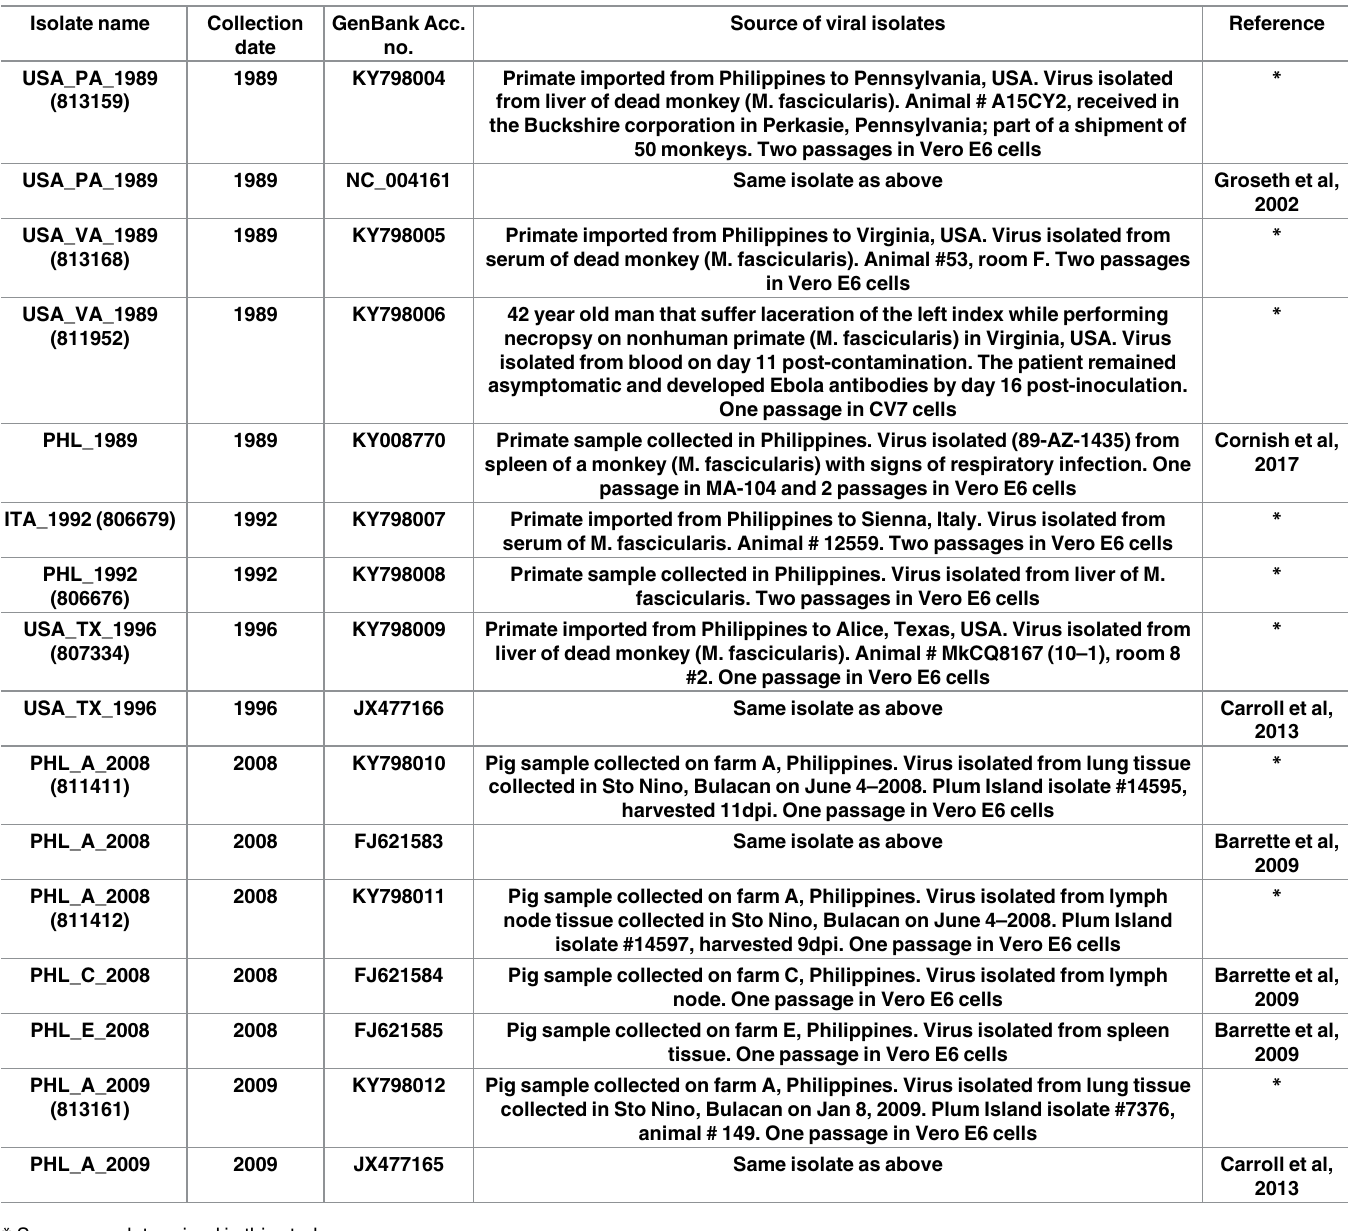
Table 1. Sequences analyzed in this